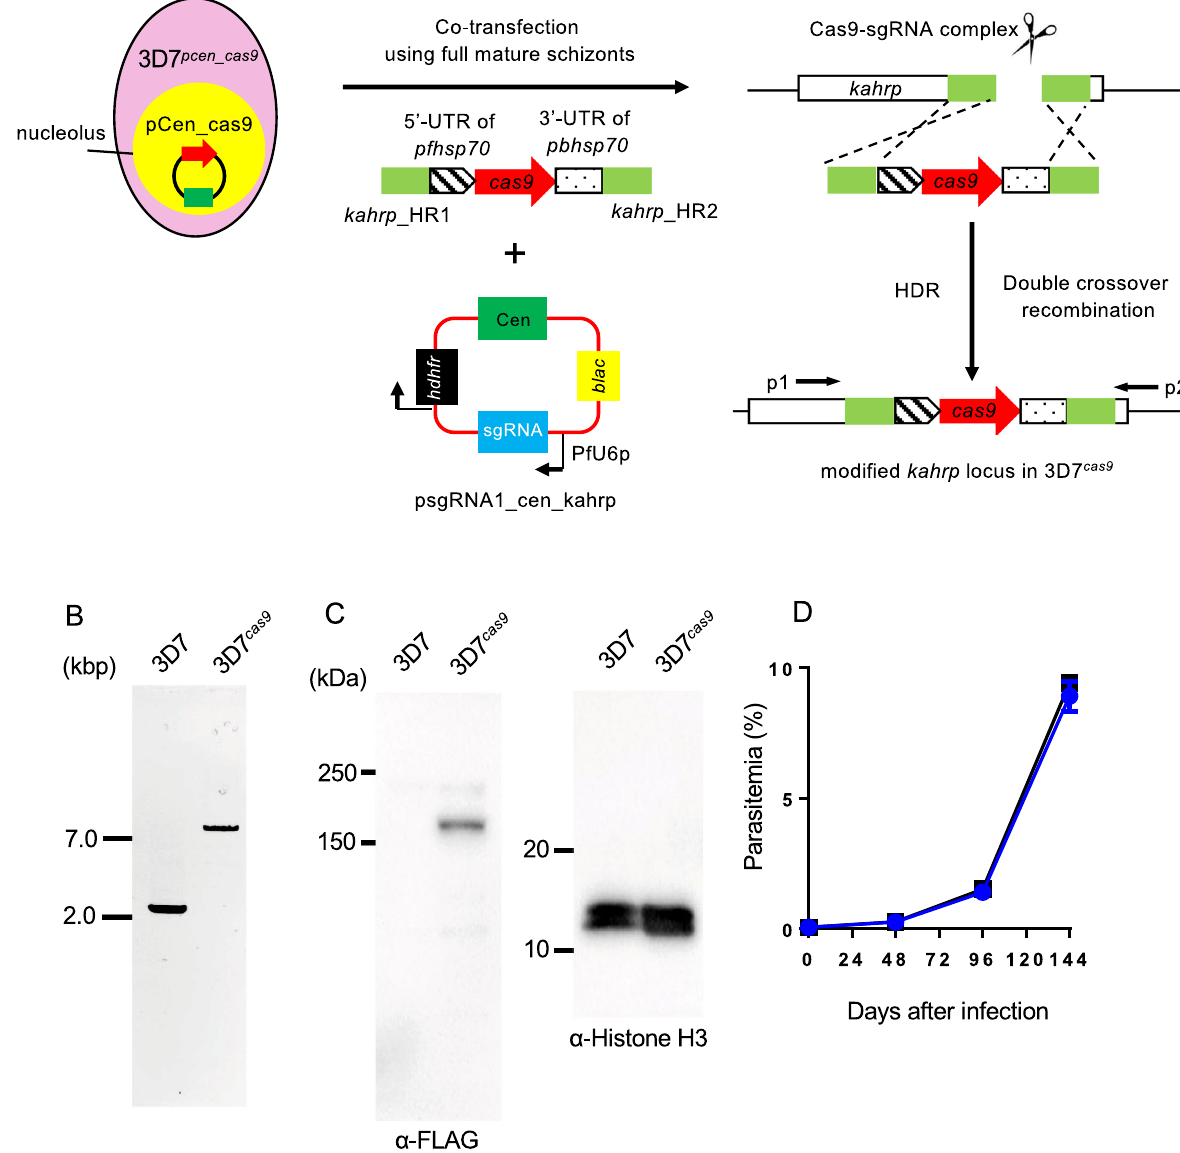
Figure 2. Generation of 3D7 cas9 . ( A ) The 3D7 pcen_cas9 parasite that maintained the pCen_cas9 plasmid was co-transfected with the Cas9 expression cassette and the psgRNA_kahrp_cen plasmid using their fully mature schizonts. The expression cassette was integrated into the kahrp locus. ( B ) Genotyping PCR of 3D7 cas9 parasites was performed using the p1 and p2 primers. Full length gel image is included in Fig. S4A. ( C ) Expression of Cas9 nuclease was confirmed by Western blot analysis using the anti-FLAG antibody. Histone H3 was used as an internal control. Full length blots are included in Fig. S4B. ( D ) The growth of 3D7 cas9 parasites (blue, circle) during asexual development in RBCs was comparable to that of wild-type parasites (black, box). Positive and negative errors were calculated from the standard error of the mean from biological triplicates. Distributions for each day were compared using the unpaired t -test (not